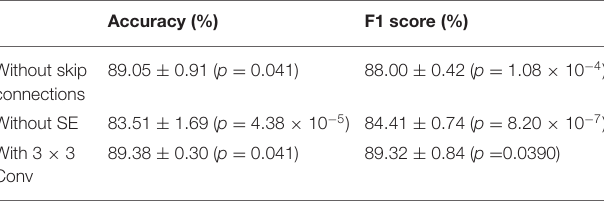
TABLE 4 | Ablation study for RISE-Net architecture (mean ± stdv).